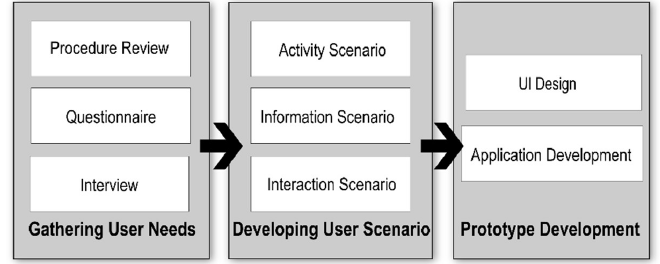
Figure 1. Collecting user requirements.